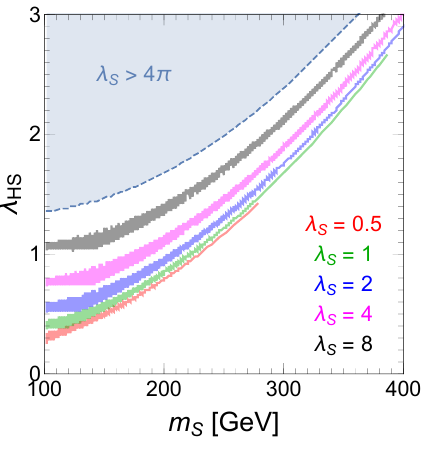
Figure 12 . The parameter space allowed by a FOPT. Different colors correspond to different λ S